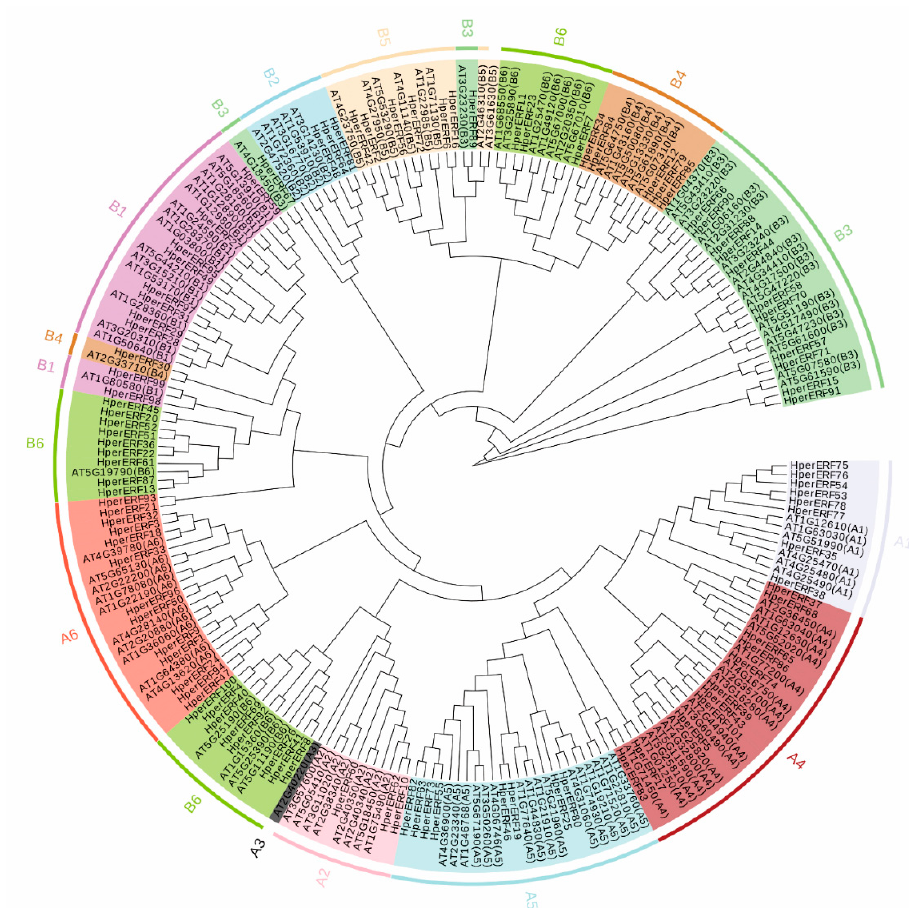
Figure 3. Phylogenetic tree of ethylene response factor (ERF) proteins from H. perforatum and Arabidopsis . The unrooted neighbor-joining (NJ) tree was constructed based on the amino acid sequences of ERFs from H. perforatum (101) and Arabidopsis (122) using MEGA6.06 with 1000 bootstrap replicates. The names of groups (A1–A6 and B1–B6) are shown outside of the circle, indicating different ERF subgroups.